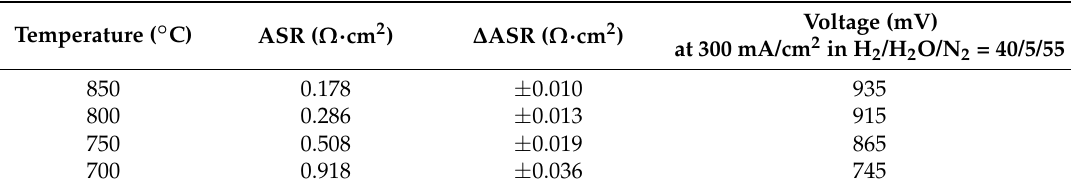
Table 1. ASR (with correction to fuel utilization) of G3 electrolyte supported cells with the optimized Ni/CGO anode based on 165 µ m 10Sc1CeSZ with scattering ( ∆ ASR) observed on different cells.